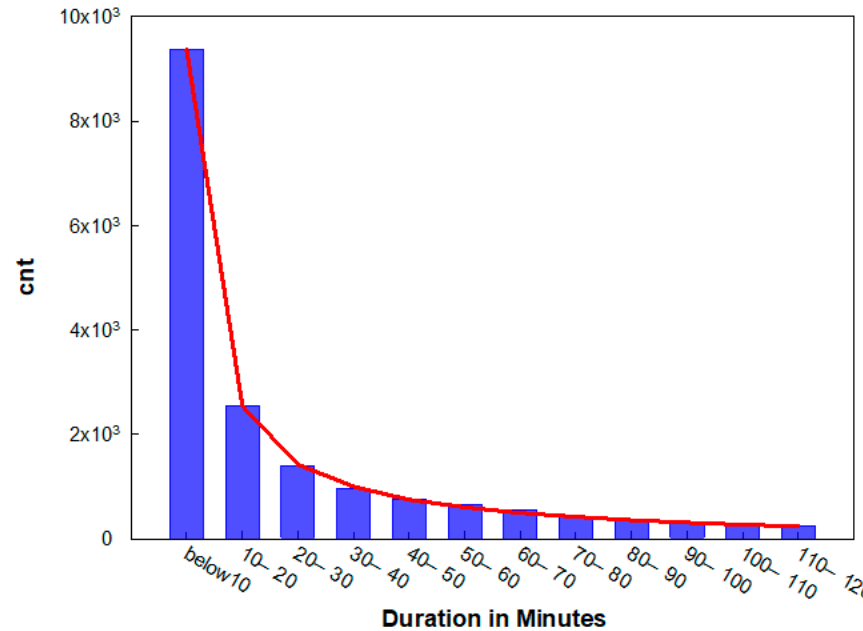
Figure 2. The number of parking with duration in minutes in a typical parking lot.